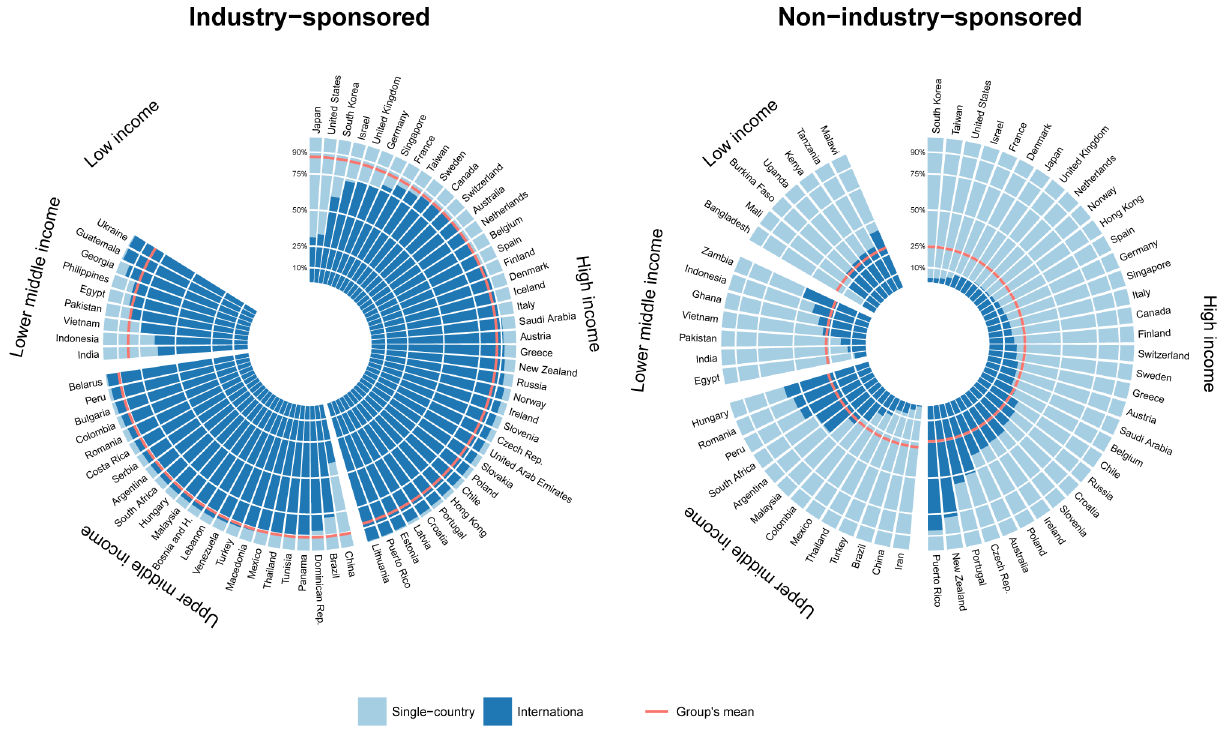
Fig 3. Collaboration ratios of industry- and non-industry – sponsored clinical trials. The radial barplot shows the proportion of international trials (in dark blue) per country for (left) industry- and (right) non-industry – sponsored trials in countries where at least 50 industry- or non-industry – sponsored trials were initiated during the 2006 – 2013 period. The 72 countries considered for industry- sponsored and the 62 countries considered for non-industry – sponsored trials were grouped by income groups. For each income group and sponsor type, the red line represents the mean proportion of international clinical trials. The exact collaboration ratios per country of industry- and non-industry-sponsored trials per country can be found on S5 and S6 Tables respectively. In all Eastern European and South American countries except Brazil, more than 90% of industry-sponsored research was international, whereas the proportion of international non-industry – sponsored research was lower and more variable, ranging from 25.0% in Colombia to 60.9% in Hungary.